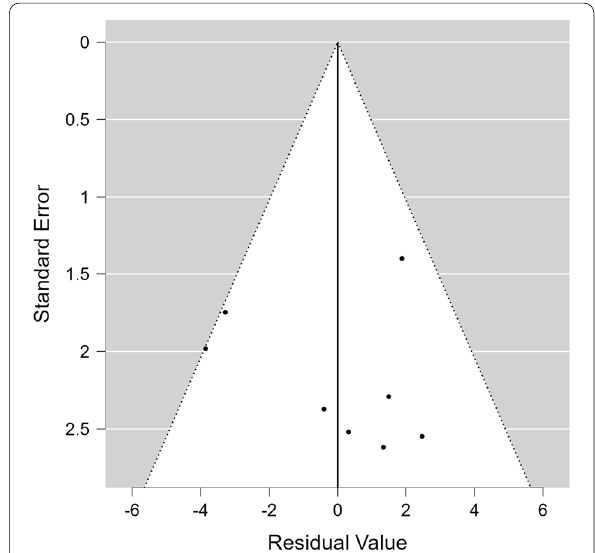
Fig. 5 Funnel plot for detection of publication